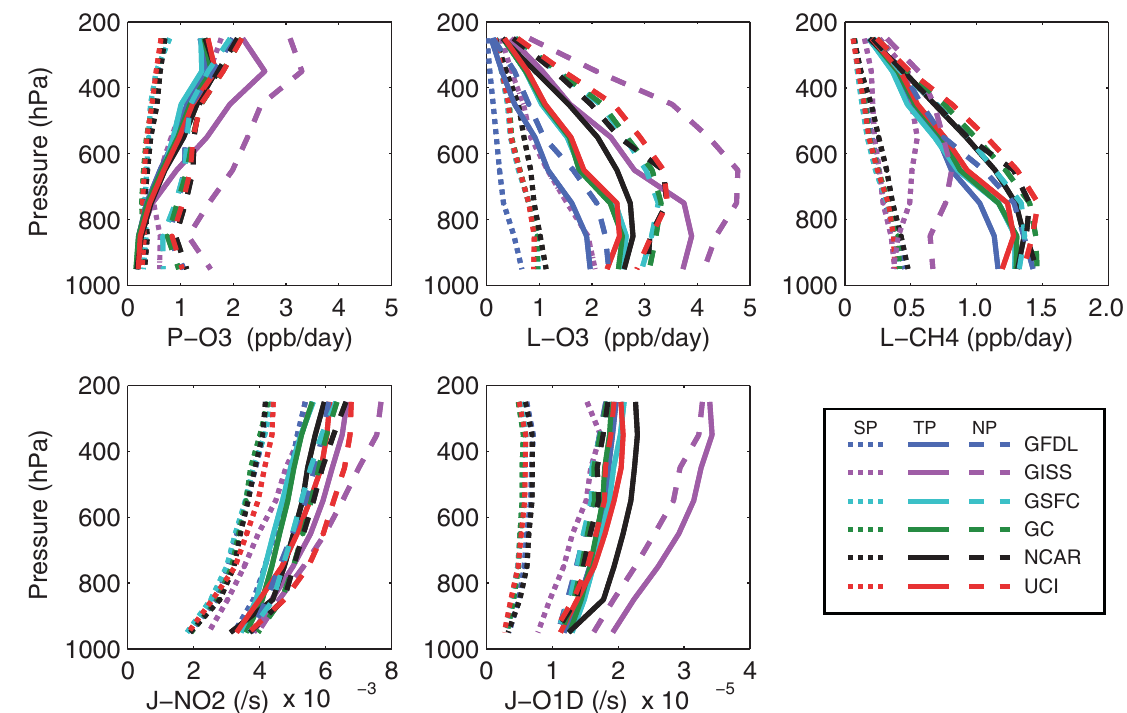
Figure 1. Different models’ profiles of reactivities ( P -O3; L -O3; L -CH4; all ppbday − 1 ) and photolysis rates ( J -NO2; J -O1D; all s − 1 ) calculated for the data stream of 14880 air parcels. Models are identified by color (black, GFDL; red, GISS; blue, GSFC; green, GC; magenta, NCAR; cyan, UCI). Latitude bands are identified by line style (solid, 20 ◦ S–20 ◦ N; dotted, 50–20 ◦ S; dashed, 20–50 ◦ N). Averages are over the five simulated dates in August, and all parcels are weighted